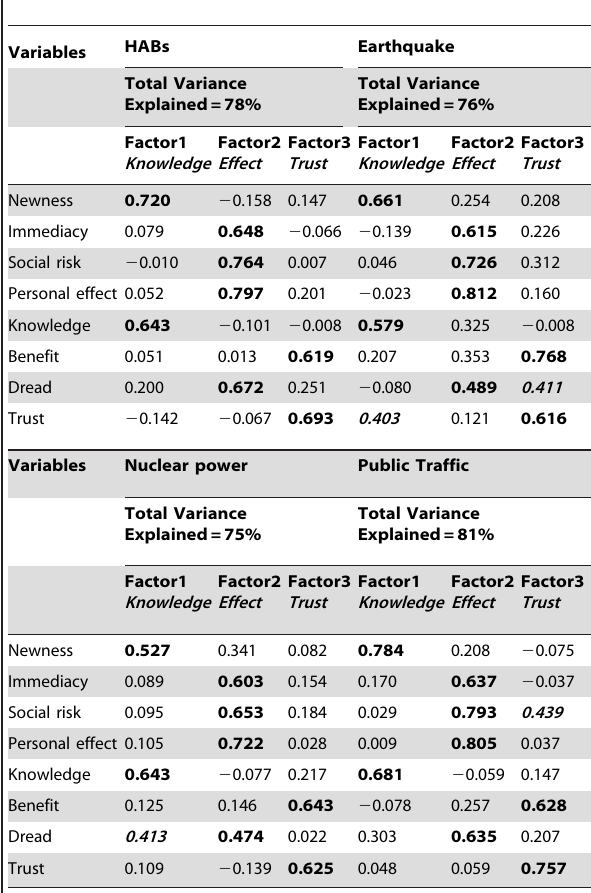
Table 4. Factor Analysis Results of Risk Characteristics about Four Typical Kinds of Risks.